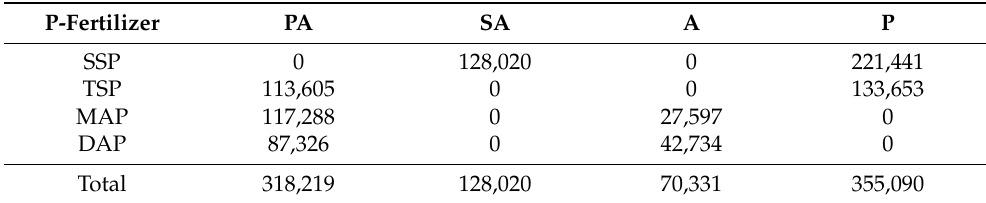
Table 11. Consumed raw materials (ton) for the production of the different fertilizers.